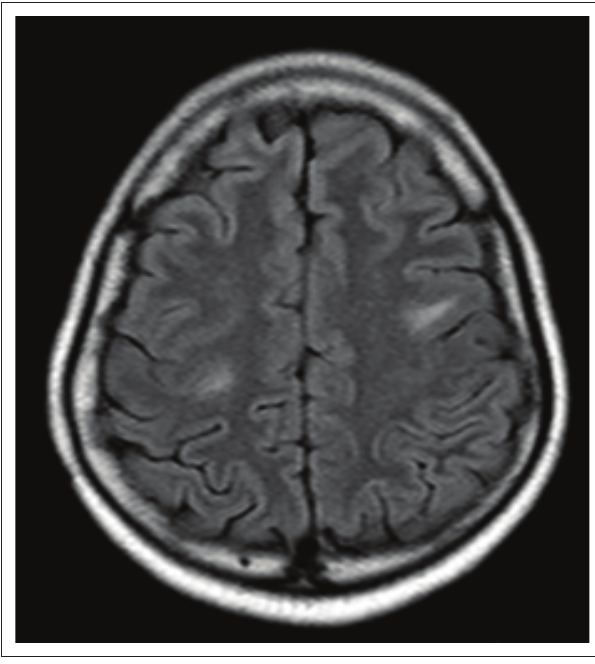
FIGURE 6: Axial T2-weighted image with hyperintense subcortical white matter